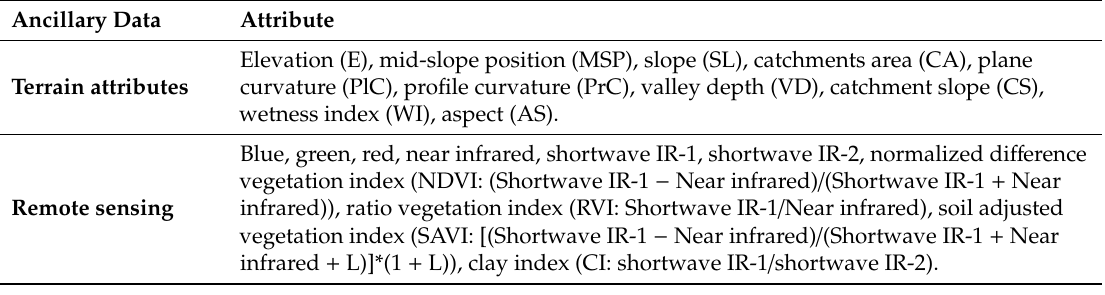
Table 2. Ancillary data used to predict soil erodibility (K) factor.